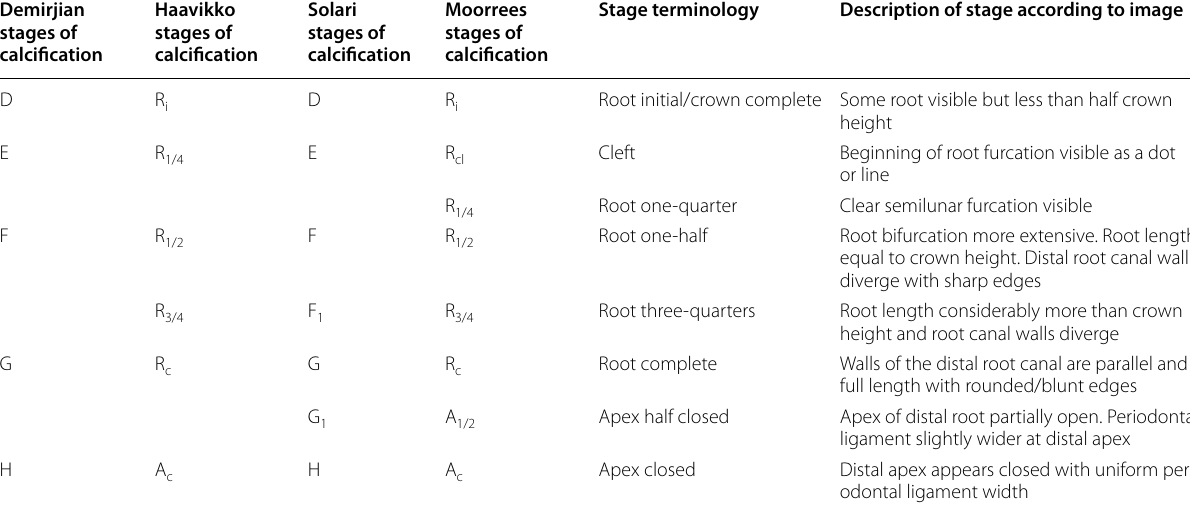
Adapted from Liversidge and Marsden (2010)